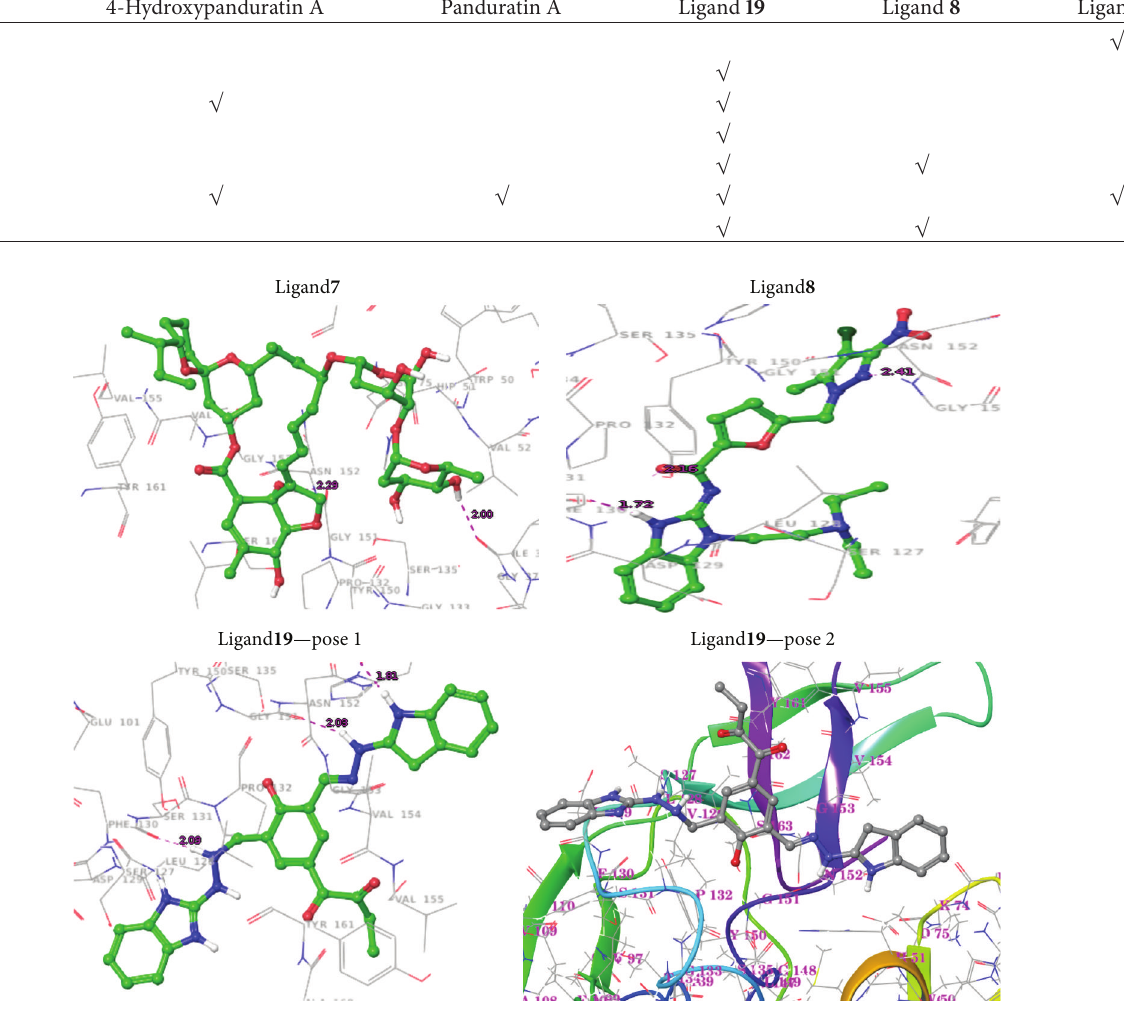
Figure 3: Interactions of ligand-protein